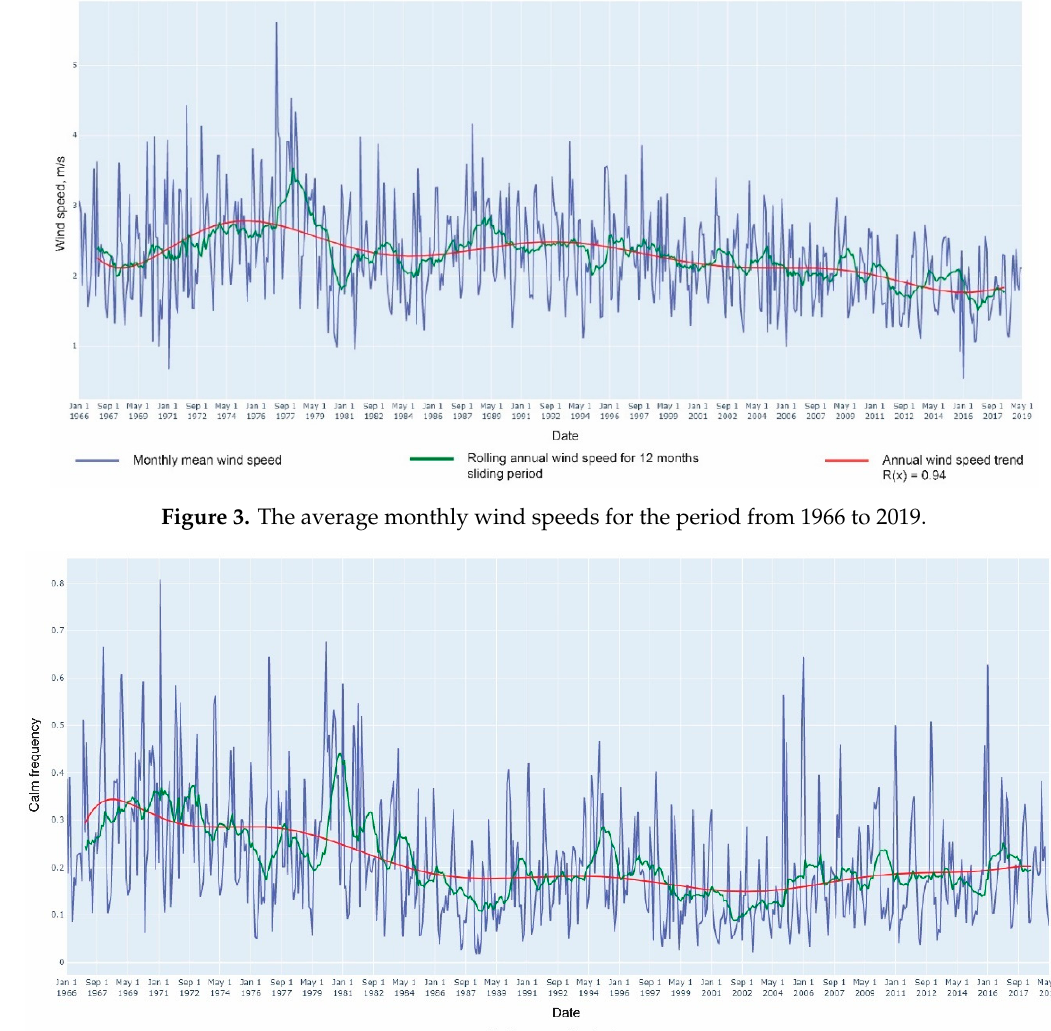
Figure 2. A heterogeneous landscape of the Krasnoyarsk greater area. Spatial distribution of the main emission sources, meteorological stations, and observation points (air quality measuring stations, AQM).